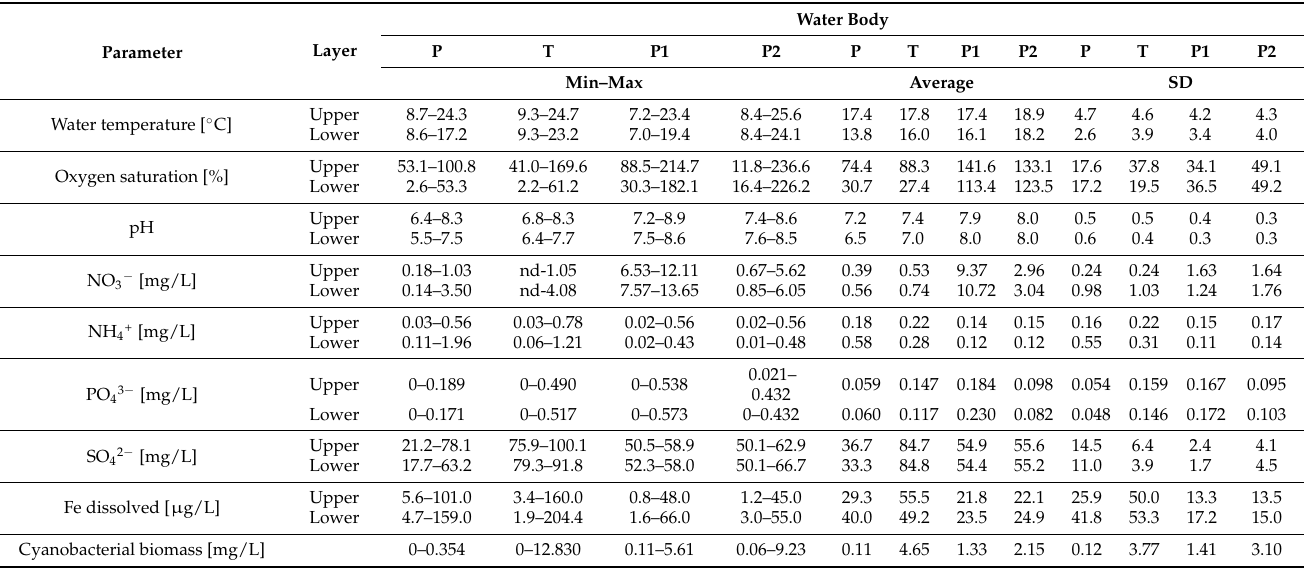
Table 2. Physico-chemical parameters of waters of the upper and lower layers of the oxbow lakes Piekary (P) and Tyniec (T) and the ponds Podkamycze 1 (P1) and Podkamycze 2